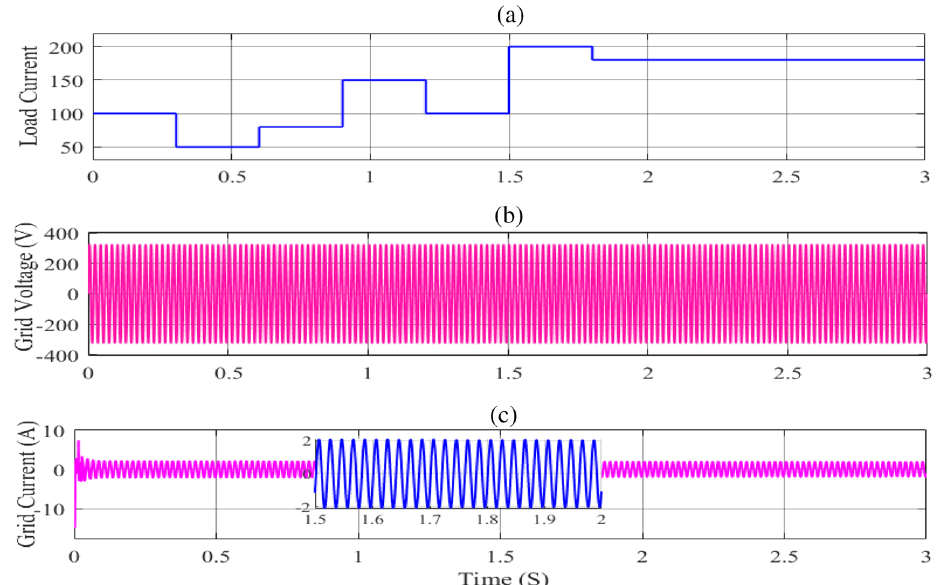
Figure 15. The Current load and AC load output under load changes. ( a ) the load current curve. ( b ) grid voltage and ( c ) grid